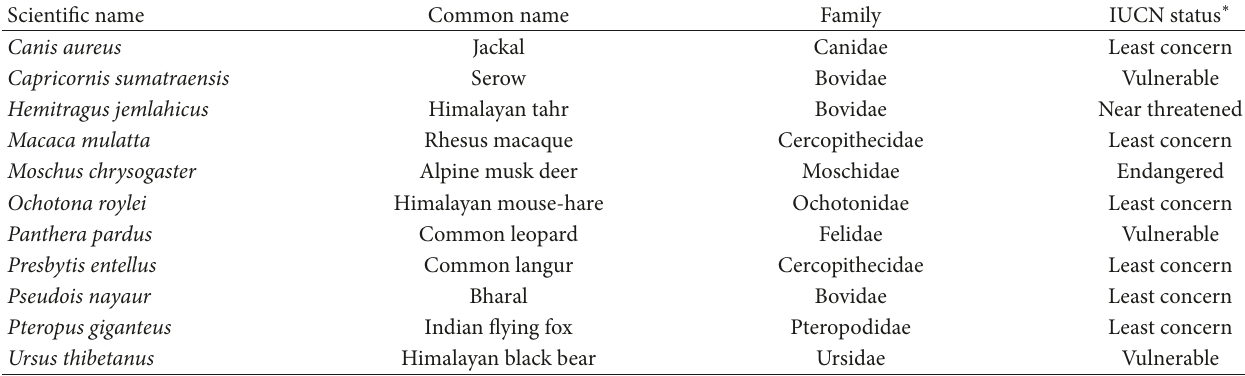
Table 9: List of animal species (with IUCN conservation status) found in Tungnath SG.